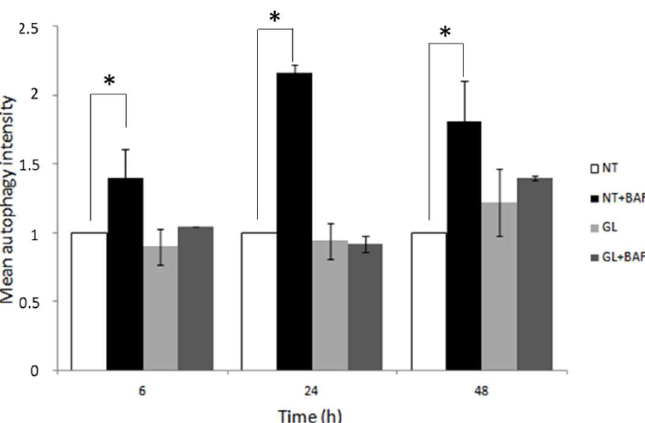
Figure 2. LC3-II expression levels in full confluent Caco-2 cells monolayer after PT-gliadin administration (GL). The LC3-II levels in Caco-2 cells cultured 5 days after confluence and treated with PT-gliadin (1 µg/µL) and bafilomycin A1 (10 nM) (BAF). Measurements were performed using a Muse ® Cell Analyzer (Merck) at different times. Results were normalized on the non-treated (NT) samples. SE bars are reported. The asterisks indicates p < 0.05, Anova one-way, as compared with NT samples. The experiments were performed in triplicate. Cytofluorimetric plots are reported in Figure S1 (Supplementary Materials).